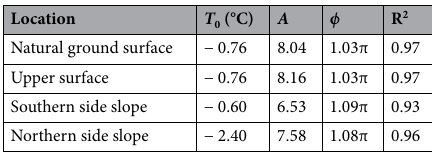
Table 2. A serial of guess values for T 0 and A , ϕ .